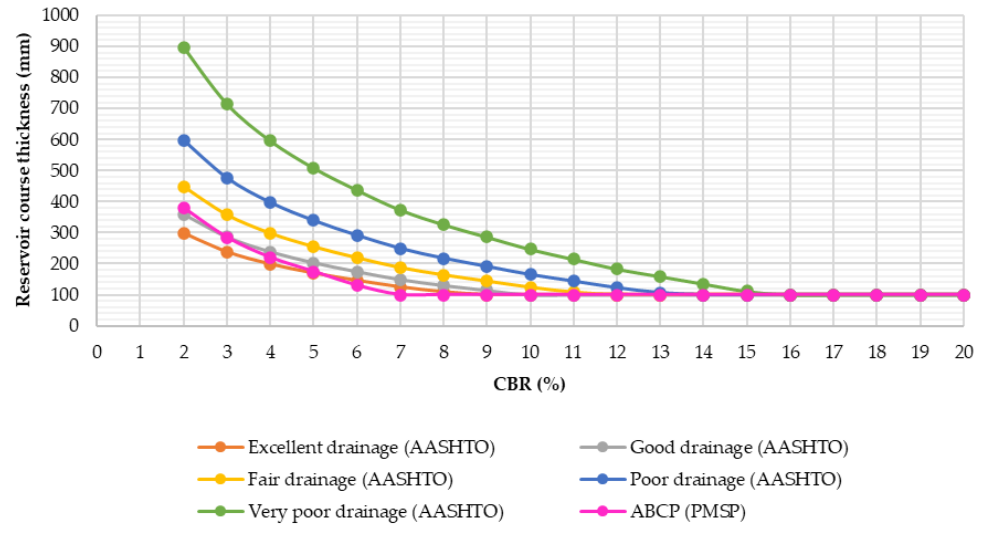
Figure 10. Structural design